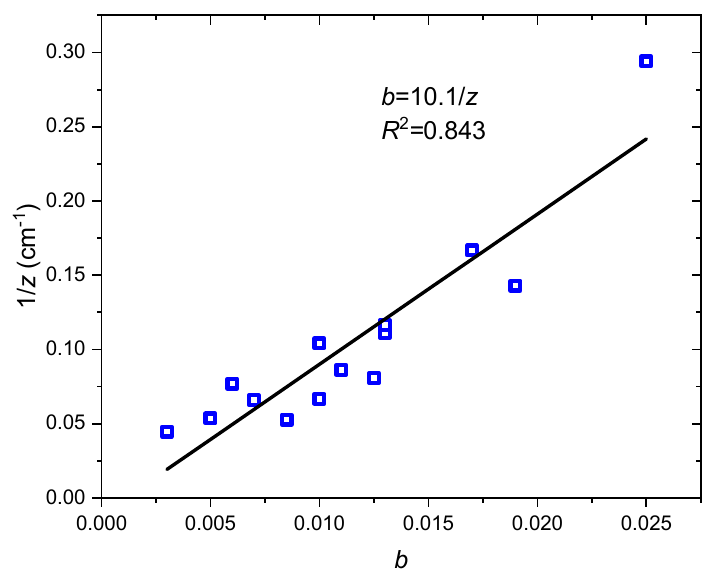
Figure 9. The relationship between b and 1/ z .